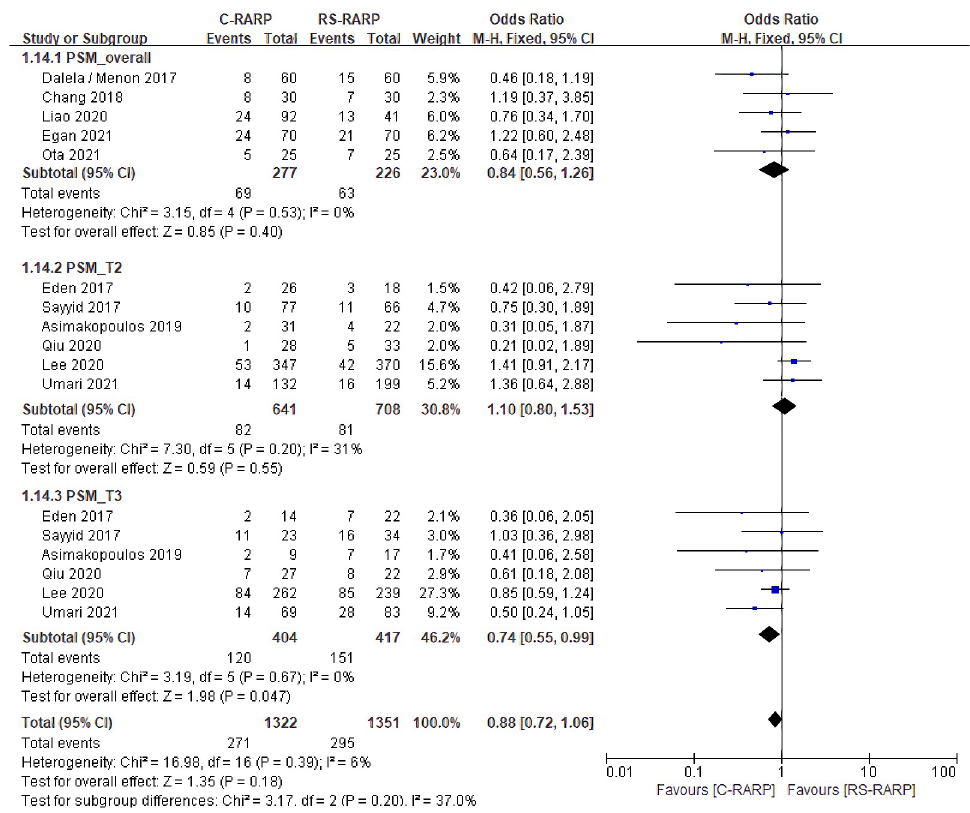
Fig 4. Forest plots of postive surgical margin (overall stage and stratified based on pathological stage).